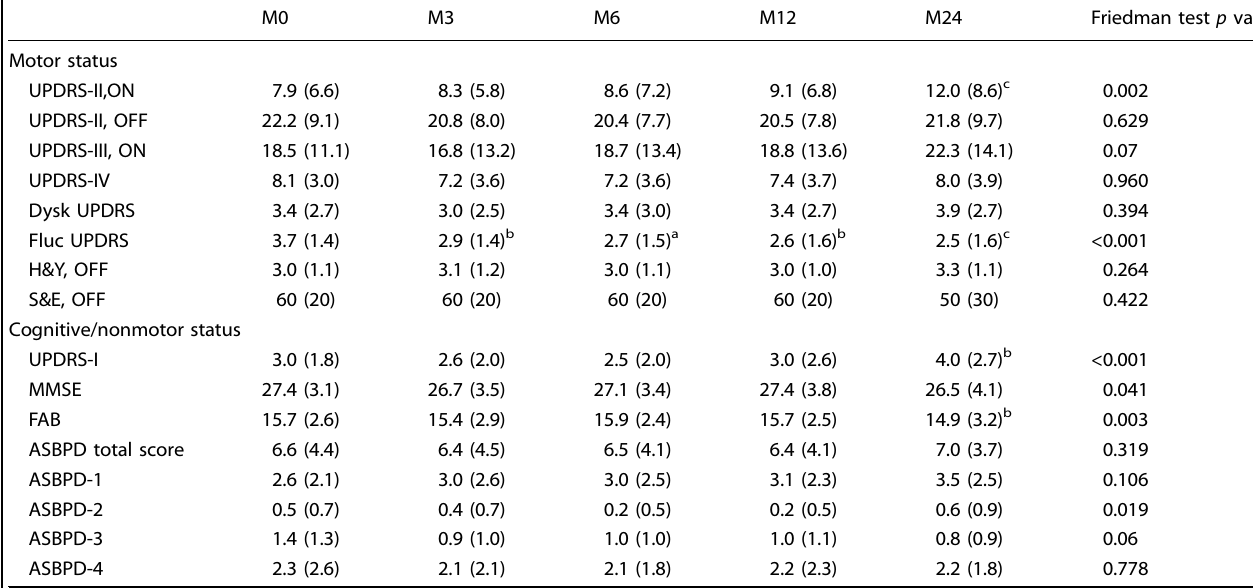
Table 3. Changes in motor, nonmotor, and cognitive dimensions with CSAI treatment ( n =